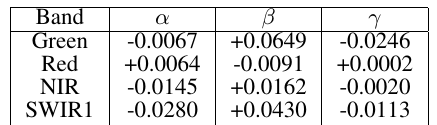
Table 1. Temporal offset model parameters of classification trees.